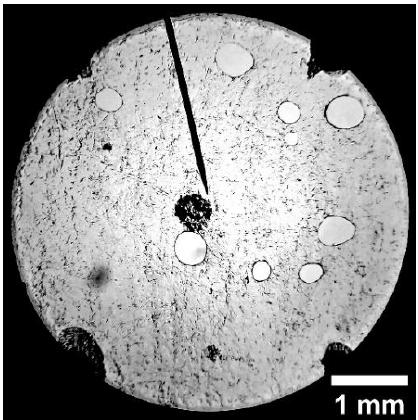
Figure 22. Example of a processed image for a 56 kGy sample.